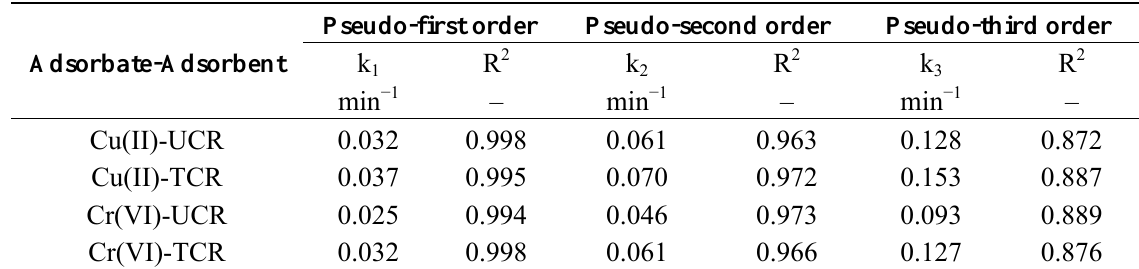
Table 1. Kinetic constants for the adsorption of Cu(II) and Cr(VI) onto coffee residues (UCR, TCR).